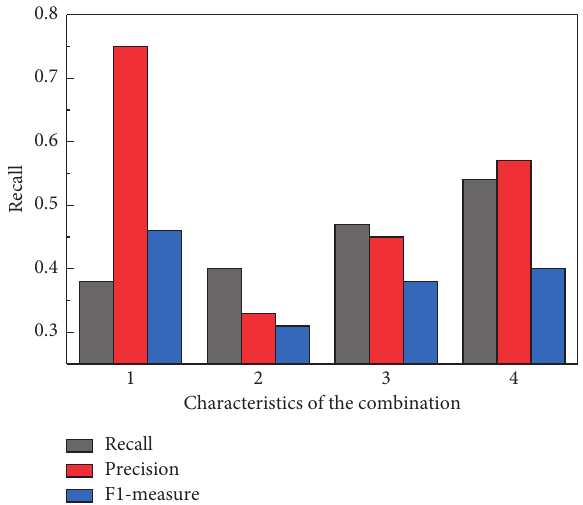
Figure 7: Student Internet access factor